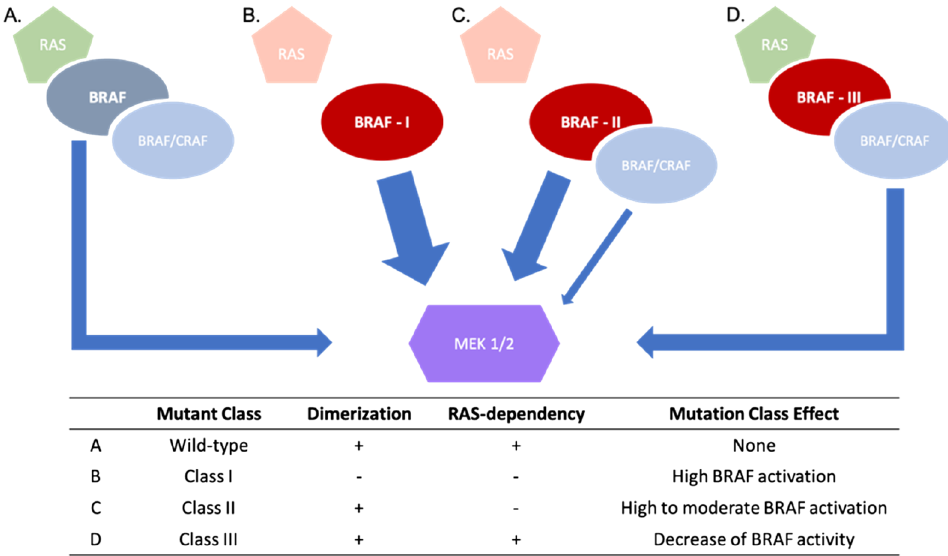
Figure 1. BRAF mutations classes. Schematic description of the wild-type, the three BRAF mutations classes and their functional impacts. The arrow width indicates the potential activation of MEK 1 and 2.